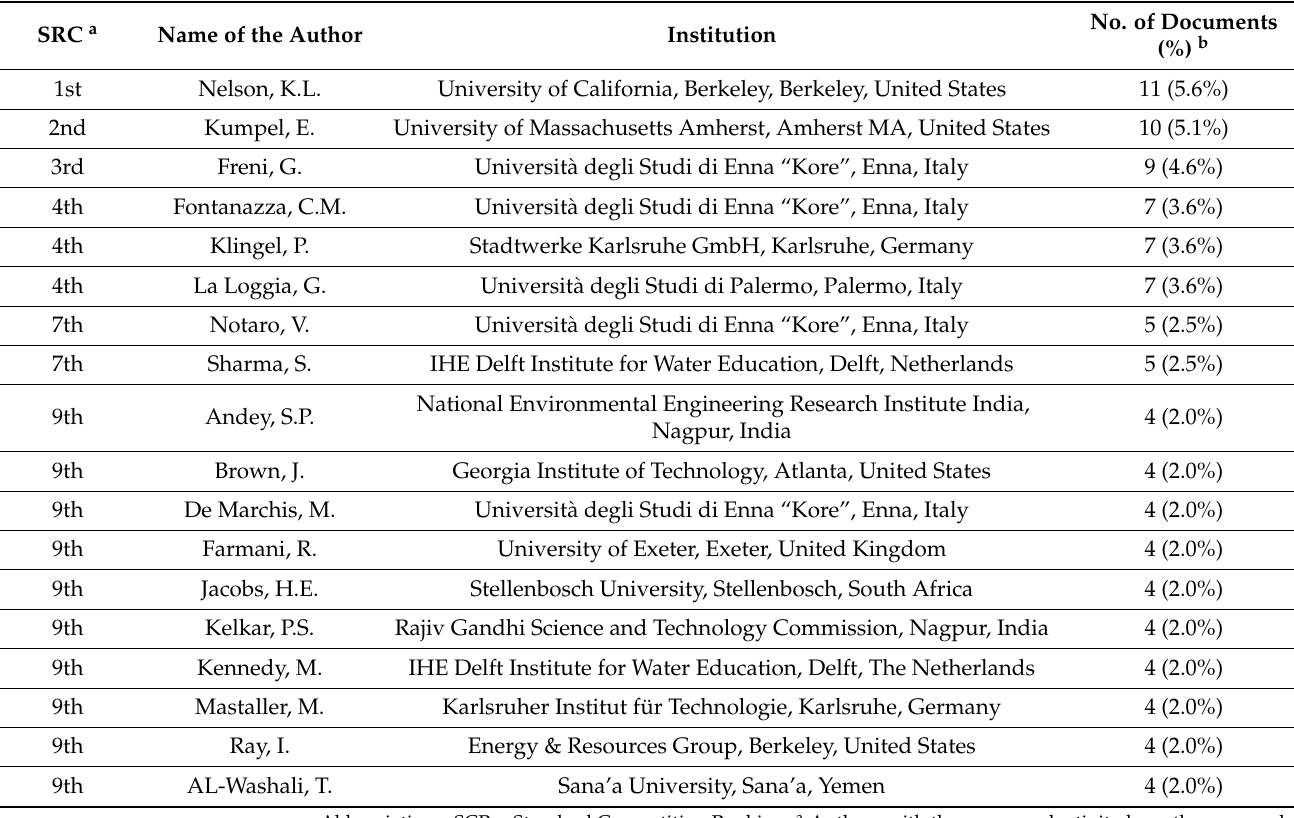
Table 4. Top 10 most prolific-authors on intermittent water supply systems (IWSSs).